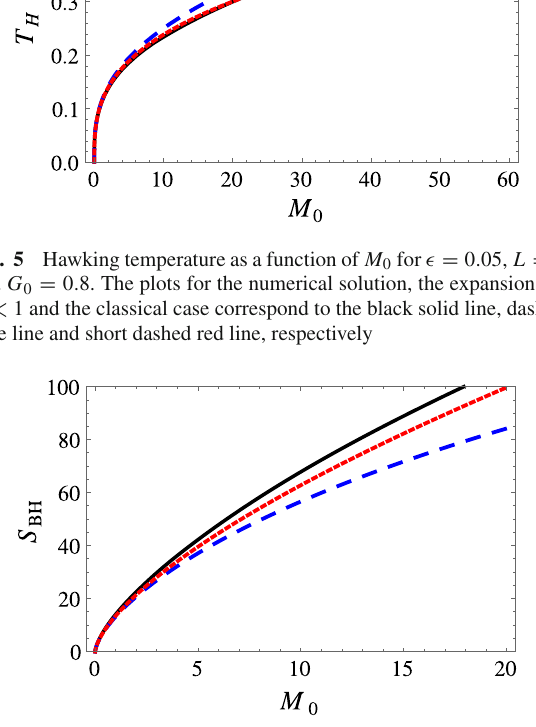
Fig. 6 Bekenstein–Hawkingentropyasafunctionof M 0 for (cid:13) = 0 . 07, L = 2and G 0 = 0 . 8.Theplotsforthenumericalsolution,theexpansion for (cid:13) (cid:12) 1 and the classical case correspond to the black solid line, dashed blue line and short dashed red line,